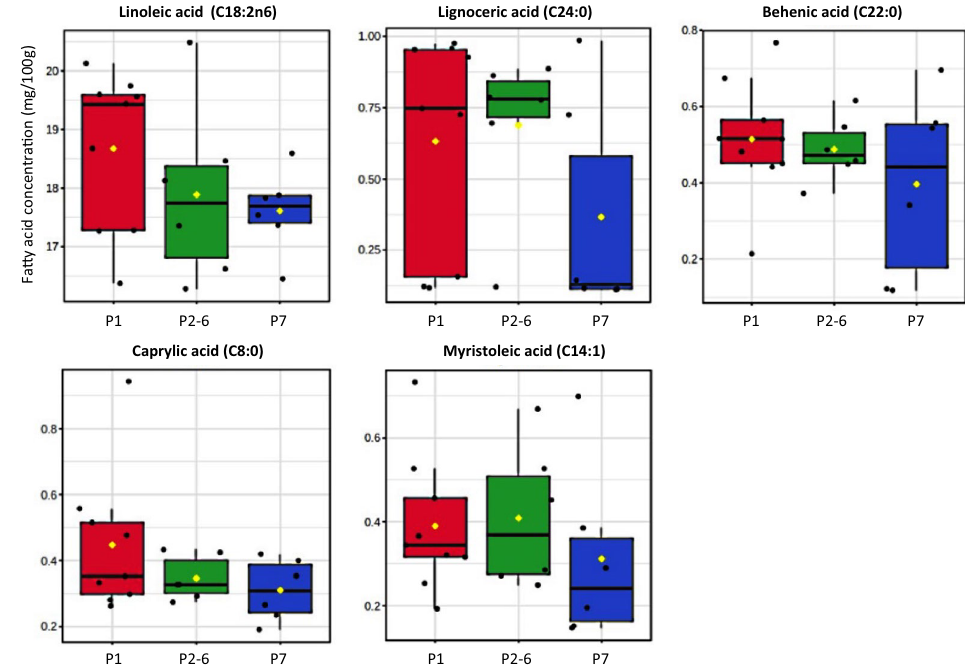
Figure 3. Box-whisker plots of comparative quantification of indicative fatty acids (mg/100 g) responsible for discrimination among mature milk samples (day 17) collected from sows in in parity 1 (red), parity 2–6 (green) and parity 7 (blue). The lower and upper edge of the box denote 25th and 75th percentile of observation, respectively; the bold line within box denotes median value; the rhombus spot within box ( (cid:31) ) denotes average value; whiskers denote 5th and 95th percentiles. For interpretation of the significant difference among mean values of samples, the reader is referred to the MIXED model statistical tests in Table